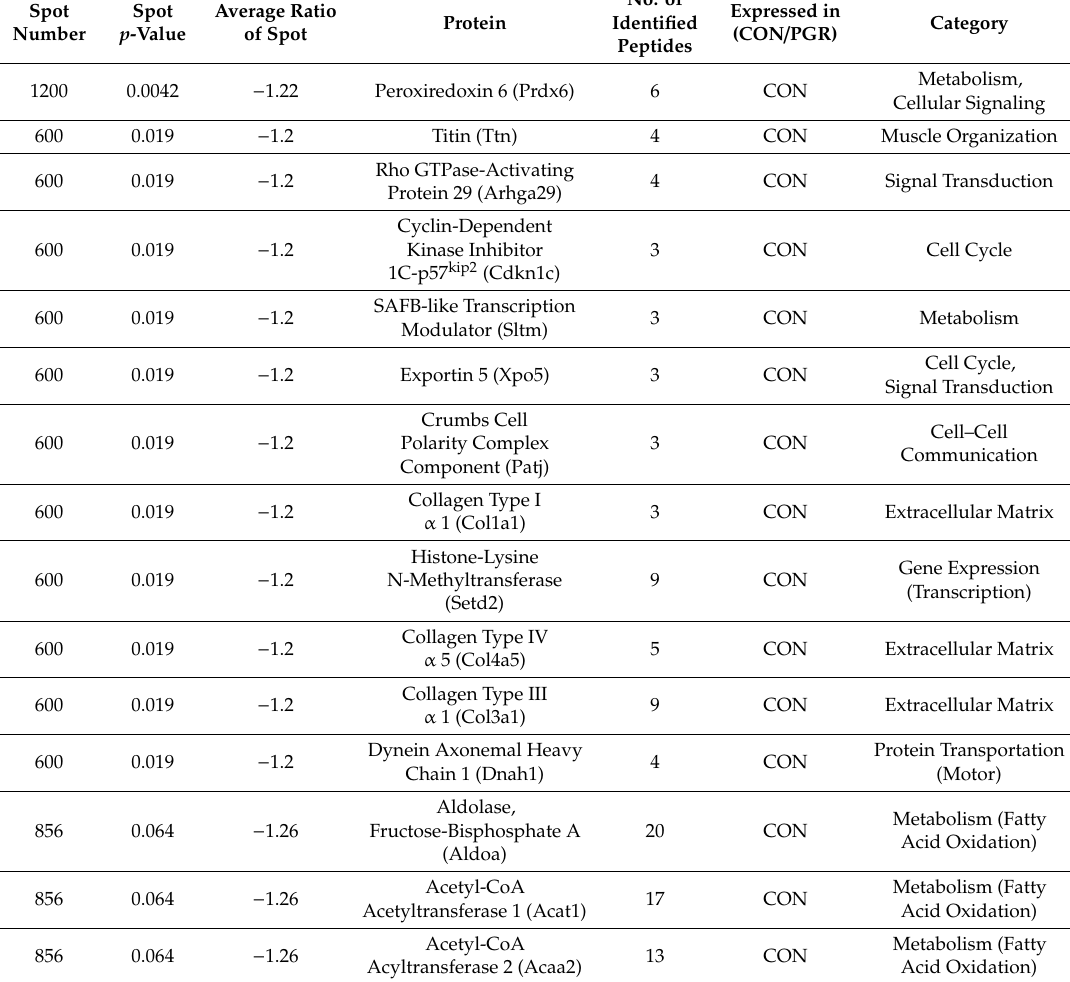
Table 1. Di ff erential protein abundance between control (CON) and growth-restricted (PGR)